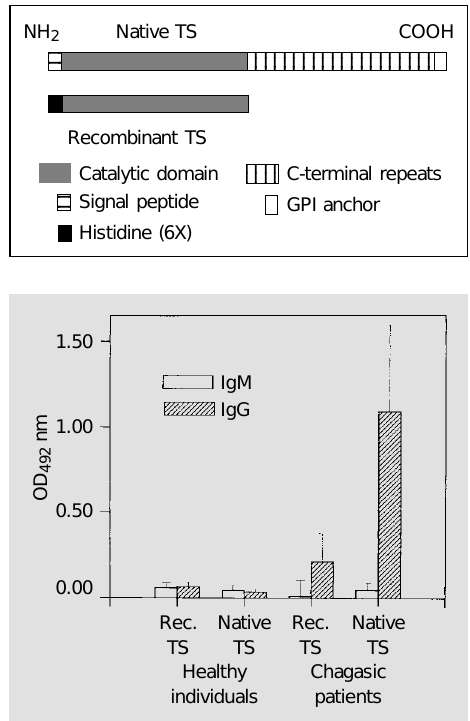
Figure 1 - Schematic view of the trans -sialidase (TS) of T. cruzi trypomastigotes and the recombinant protein based on the N-terminal region.